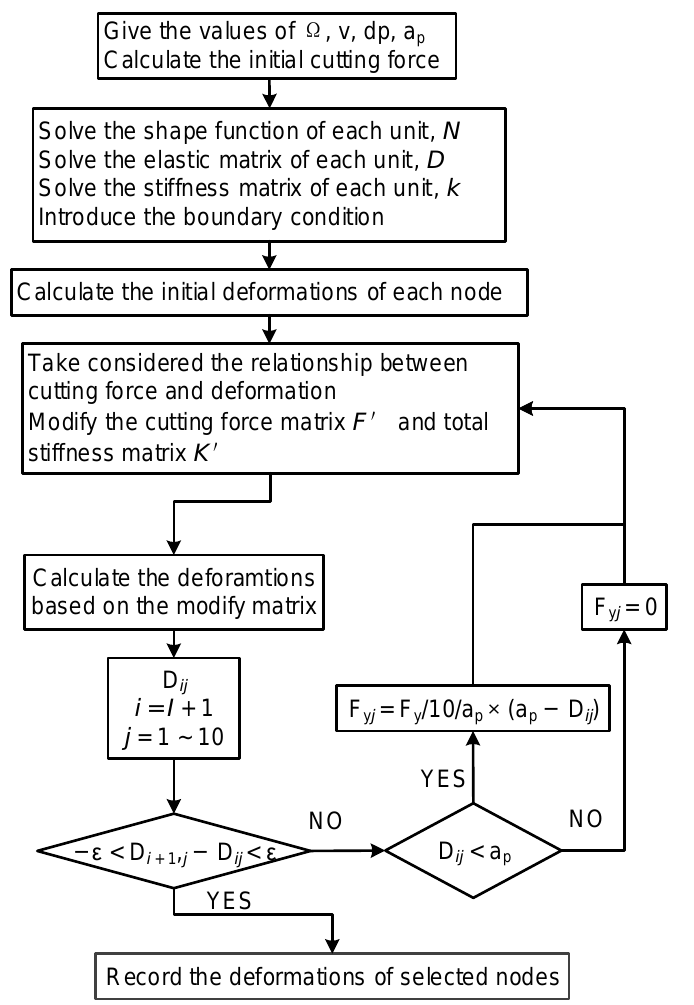
Figure 5. Analyzed flow chart of micro thin-walled structure deformation.